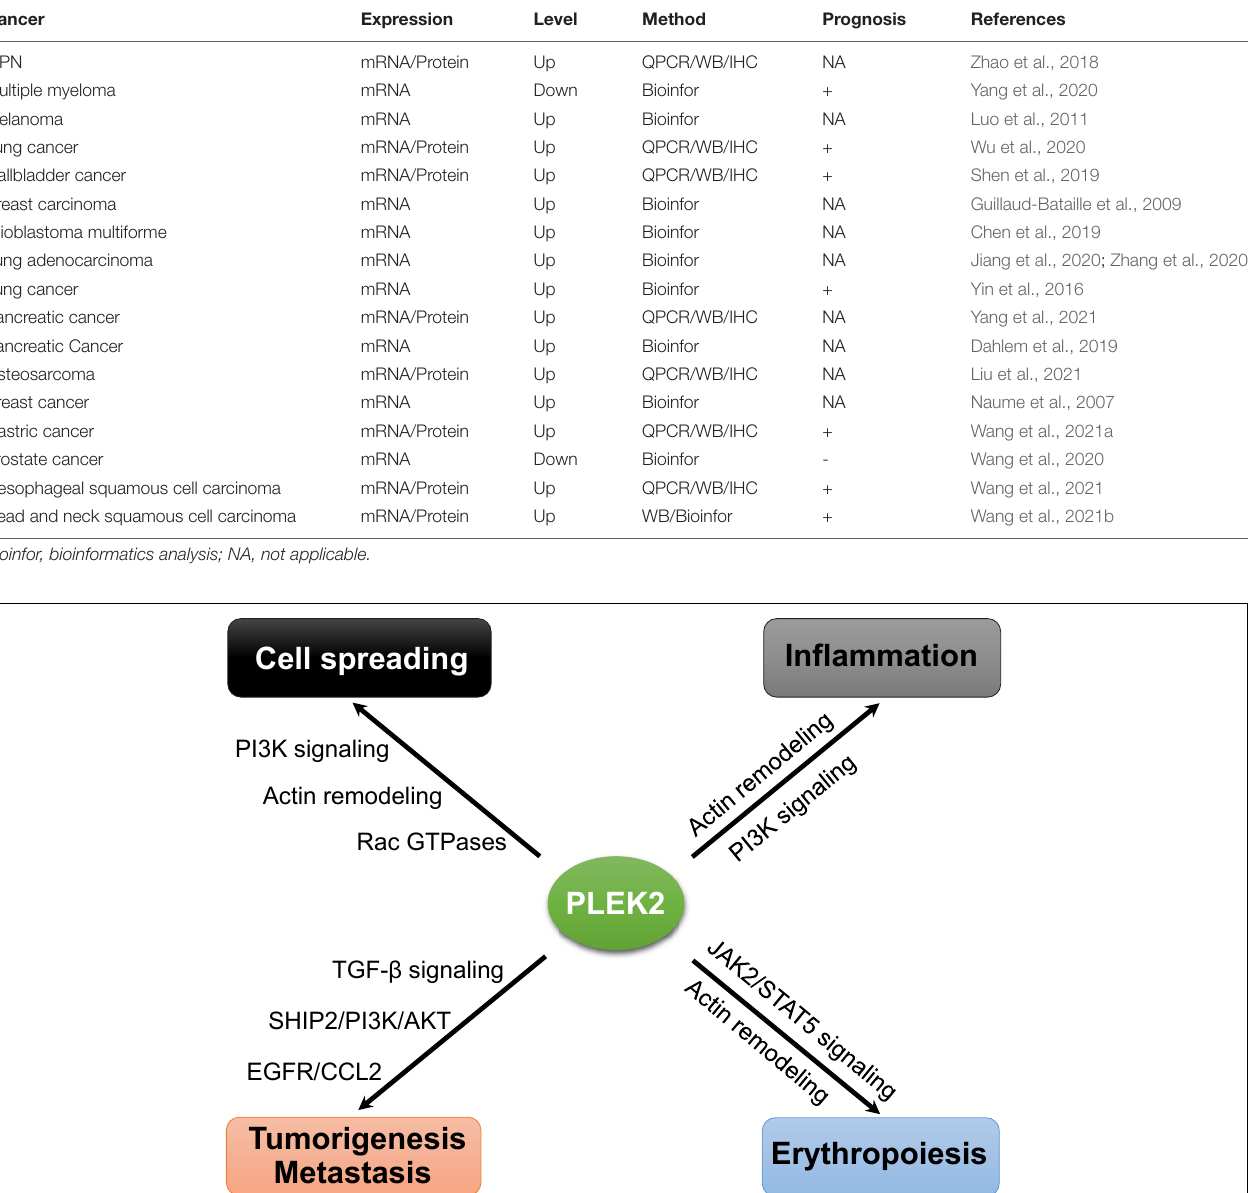
TABLE 3 | Dysregulation of PLEK2 in cancer.